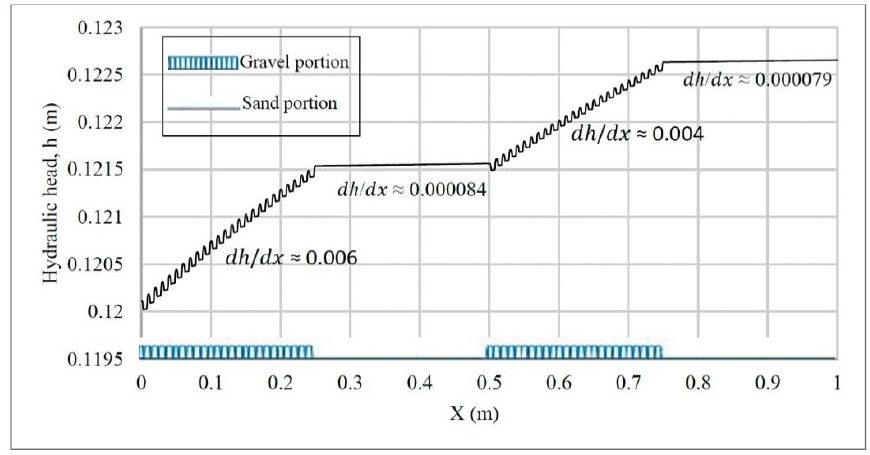
Figure 9. Distribution of hydraulic head over the length of stream bed. The graph above depicts the base case scenario: gpt10 × 10, where the height and base width of gravel piece was 10 m.